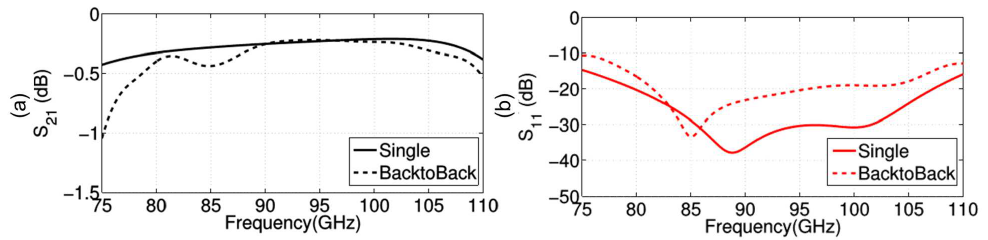
Figure 8. Simulation of the scattering parameters for the microstrip to standard WR-10 single (solid line) and back-to-back transitions (dashed line), second prototype: ( left ) insertion loss and ( right ) return